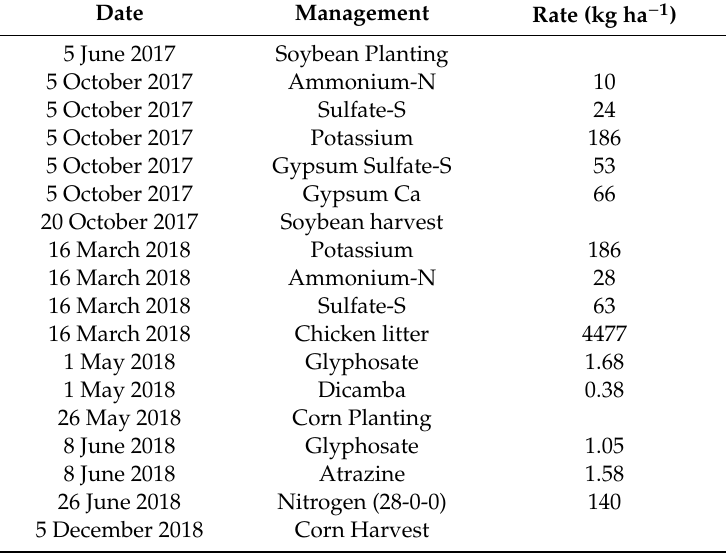
Table 1. Field management practices implemented at the field site during the blind inlet monitoring period, regarding the application of chemicals, nutrients, and planting and harvest